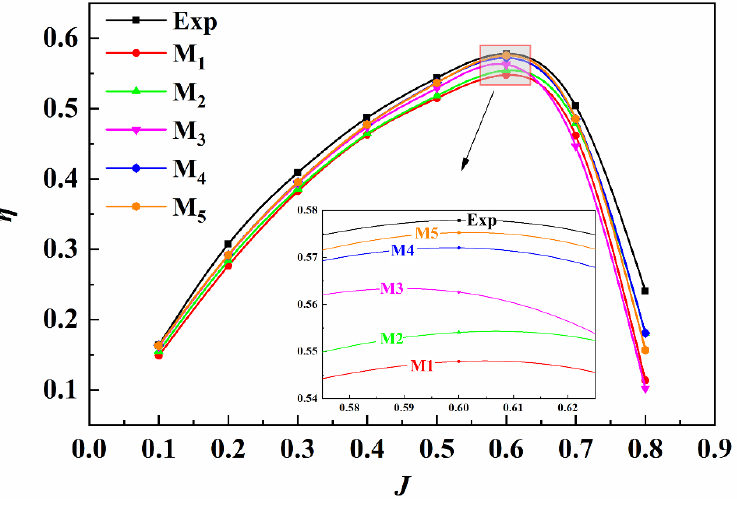
Figure 6. Comparison of the experimental and simulated values of the efficiency η . A common advance speed coefficient of the Ka4-70 propeller in the 19A duct is 0.6.